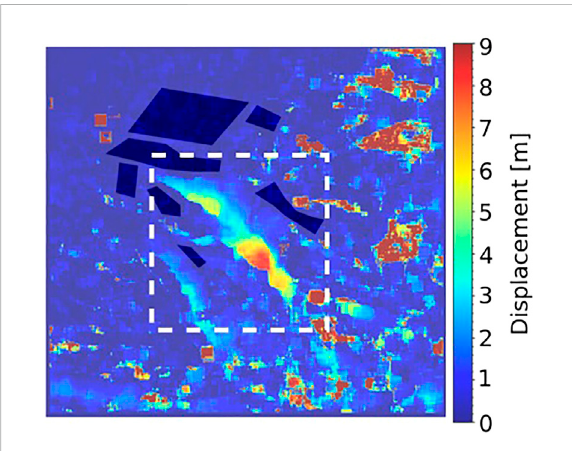
FIGURE 8 Dark blue polygons correspond to the stable areas selected to compare LabSAR and EFIDIR uncertainties. It is superimposed over displacement magnitudes between the 28/09/2020 and 09/ 10/2020 images. These displacements have been computed with the full EFIDIR pipeline in m and are represented with colors rangingfrombluetored.Theoutliershavenotbeen fi lteredoutfor this study and appear in dark red: they are due to temporal decorrelation, lack of feature or point target due to cars (north-